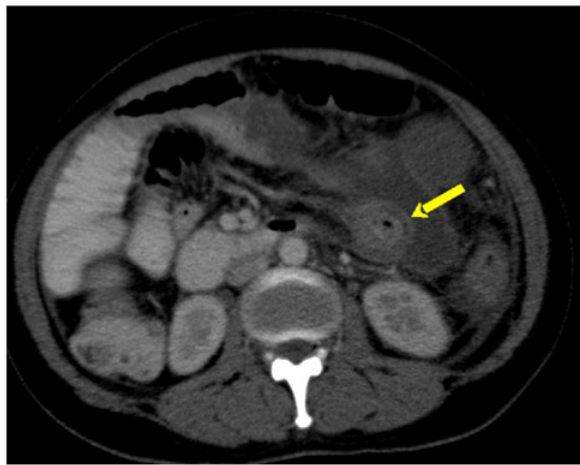
Figure 8a: Axial CT showing bulls-eye or target appearance in which there are alternating layers of high and low attenuation due to mural hyperenhancement and submucosal oedema (arrow)